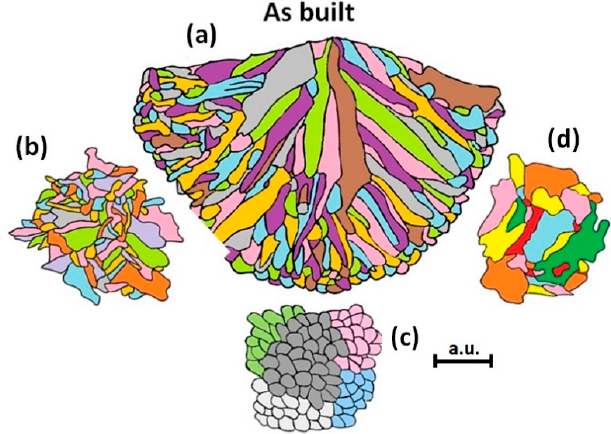
Figure 4. Microstructural approach through a schematic illustration (made from [37,39,42–45]) of the Cantor alloy manufactured by laser additive manufacturing methods in the “as built” condition. ( a ) Epitaxial configuration with columnar grains in the built direction, ( b ) random columnar grains, ( c ) granular grains and ( d ) nearly equiaxial grains. The magnification mark is arbitrary due to the different papers used but is in the range of 40–80 µm.